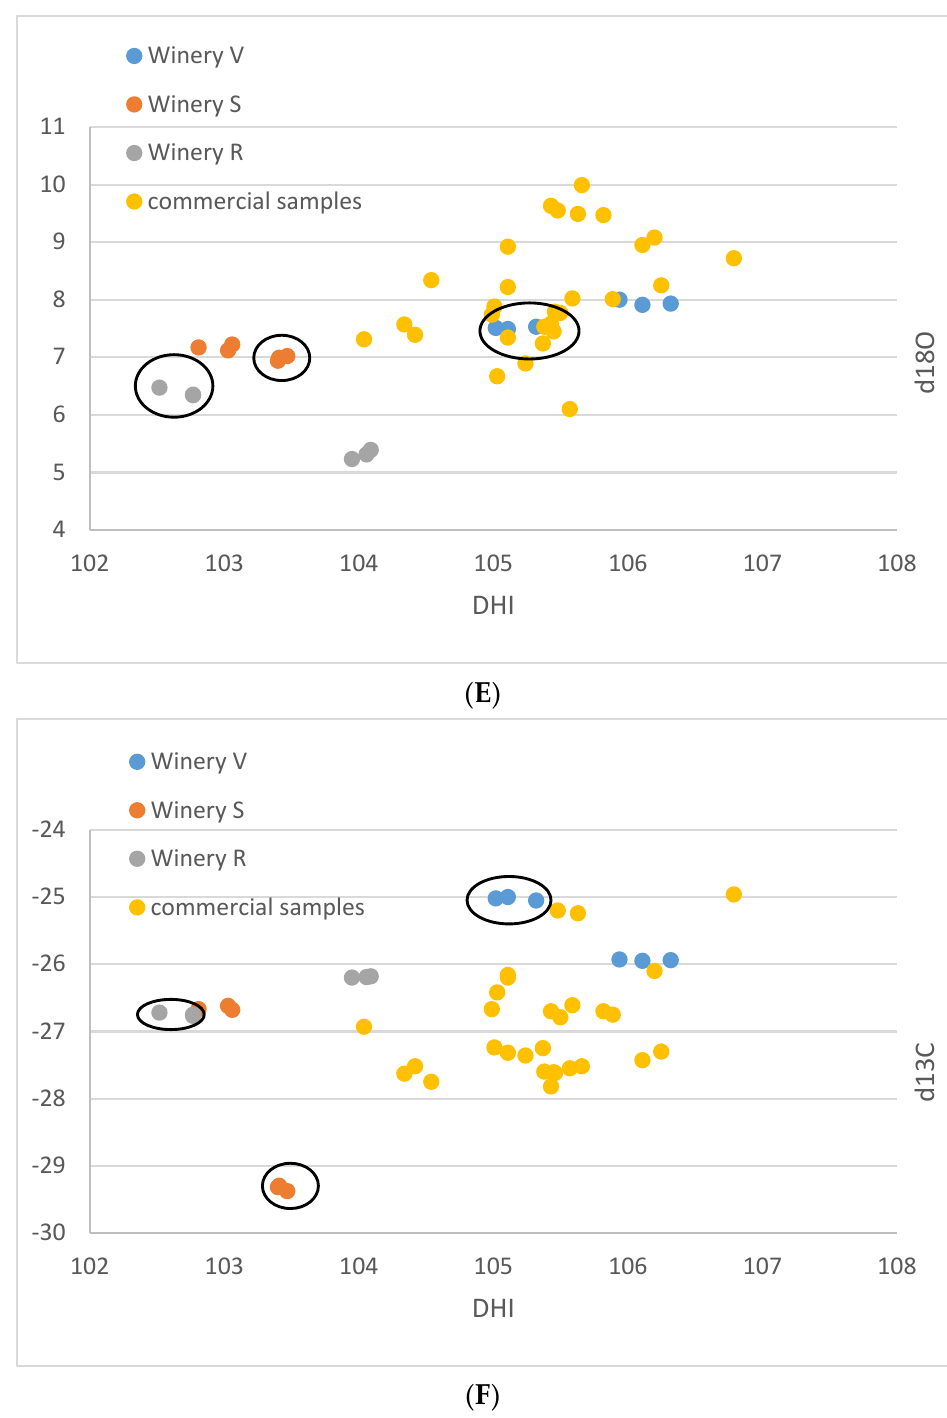
Figure 1. ( A – F ): Isotope results of the South African samples in ‰ versus V-PDB for δ 13 C, in ‰ versus V-SMOW for δ 18 O, and in ppm for (D/H)I and (D/H)II. ( A ): δ 13 C versus δ 18 O. ( B ): (D/H)I versus (D/H)II. ( C ): (D/H)II versus δ 18 O, ( D ): (D/H)II versus δ 13 C, ( E ): (D/H)I versus δ 18 O, ( F ): (D/H)I versus δ 13 C. Ellipses identify the Sauvignon Blanc from the Chenin samples of the small-scale samples of the wineries R, S, V.